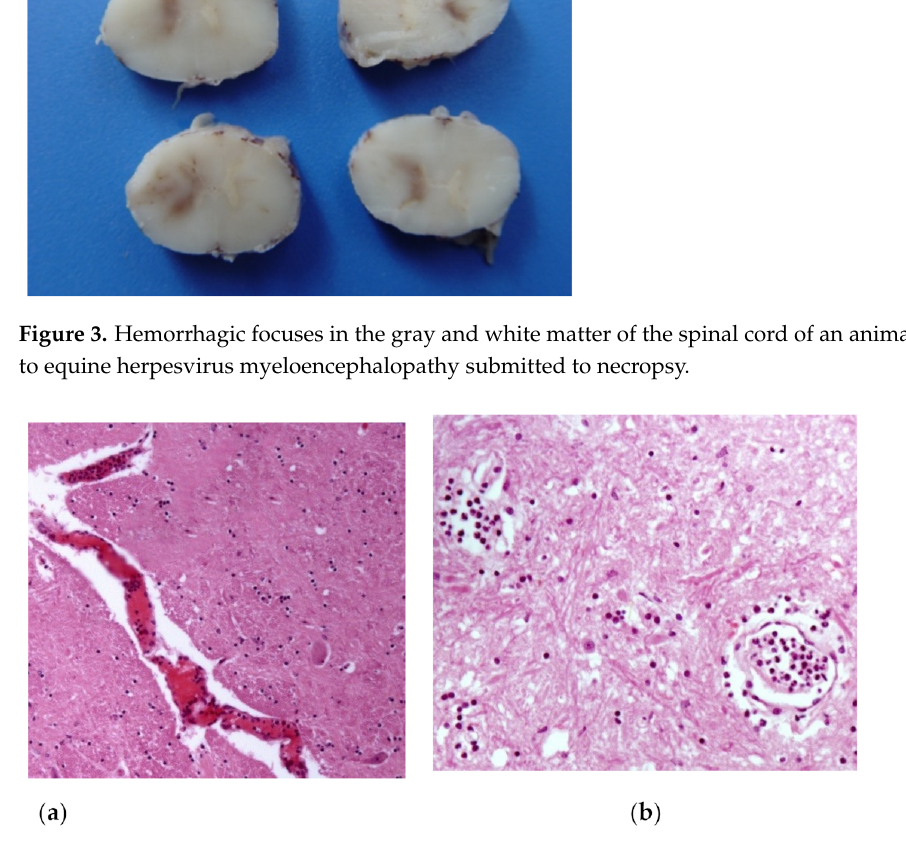
Figure 4. Microscopic changes observed of an animal submitted to necropsy (Obj. 20, H.E.): ( a ) con- gestion, perivascular edema and predominantly neutrophilic vasculitis in the leptomeninges of the spinal cord; ( b ) perivasculitis and neutrophilic vasculitis in the spinal cord gray